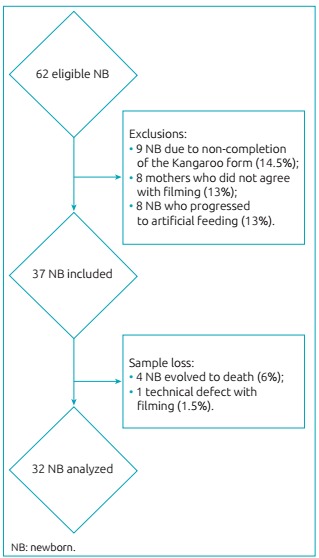
Flowchart with the distribution of the eligible sample, the losses, and the sample analyzed.